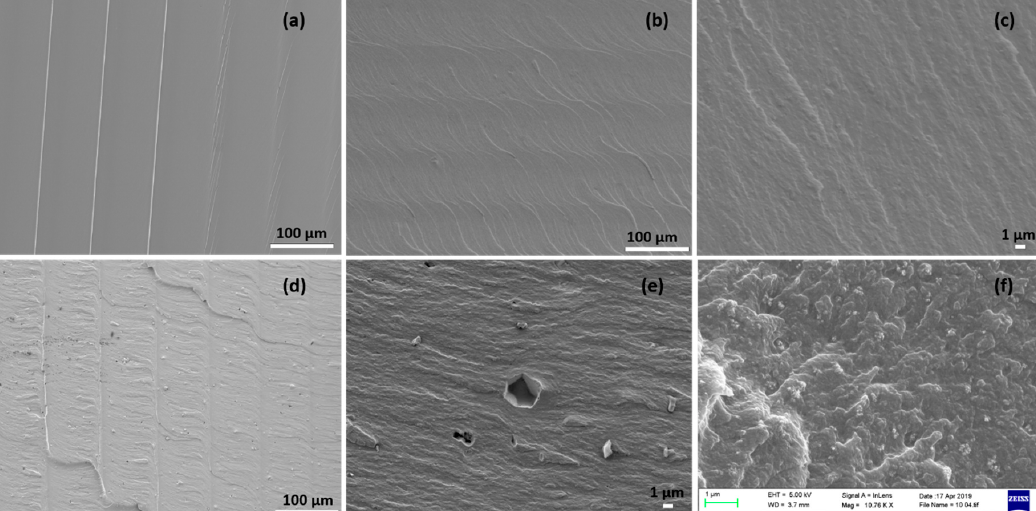
Figure 5. SEM images of the fractured surface of the DPP 3DP ( a ) un-filled photopolymer, ( b–c ) 10% w/v TO composite (low and high magnifications), ( d–e ) 10% w/v CCT composite (low and high magnifications);,and ( f ) state of dispersion of TO in the 10% w/v TO/photopolymer